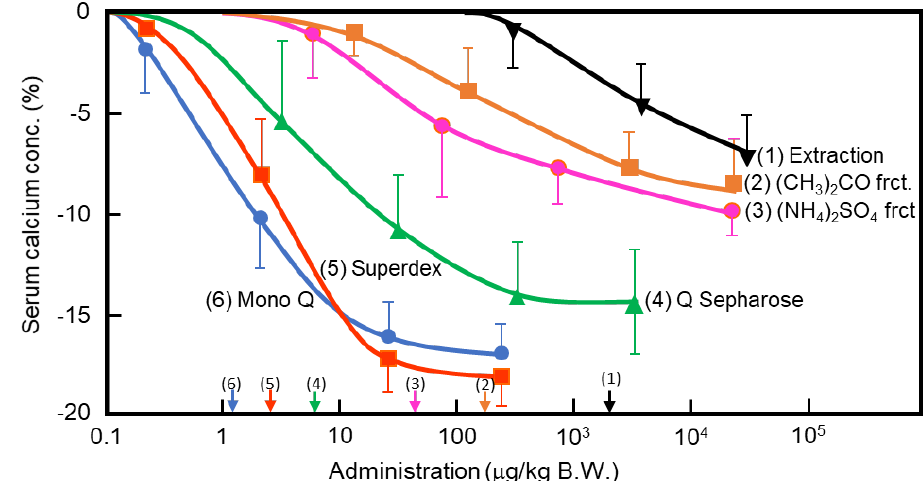
Figure 1. Purification of porcine caldecrin and its serum calcium-decreasing activity. The caldecrin was isolated from porcine pancreas following the following purification steps: porcine acetone powder was extracted (1), and active fraction was separated with acetone (CH 3 ) 2 CO precipitation (2), saturated ammonium sulfate (NH 4 ) 2 SO 4 precipitation (3), and then Q Sepharose Fast–Flow ion-exchange chromatography (4), Superdex 75 size–exclusion fast protein liquid chromatography (FPLC) (5), and Mono Q ion–exchange FPLC (6). Dose–dependent curves of serum calcium decreased activity and its half maximal effective concentration (EC50) values, as shown by arrows on the x -axis, were prepared from the representative preparation.